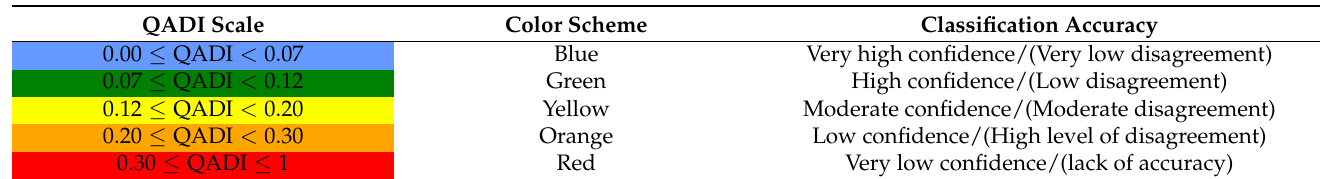
Table 2. Calibration for QADI and benchmarks for the strength of the classification accuracy. QADI Scale Color Scheme Classification Accuracy Blue Very high confidence/(Very low disagreement) Green High confidence/(Low disagreement) Yellow Moderate confidence/(Moderate disagreement) Orange Low confidence/(High level of disagreement) Red Very low confidence/(lack of